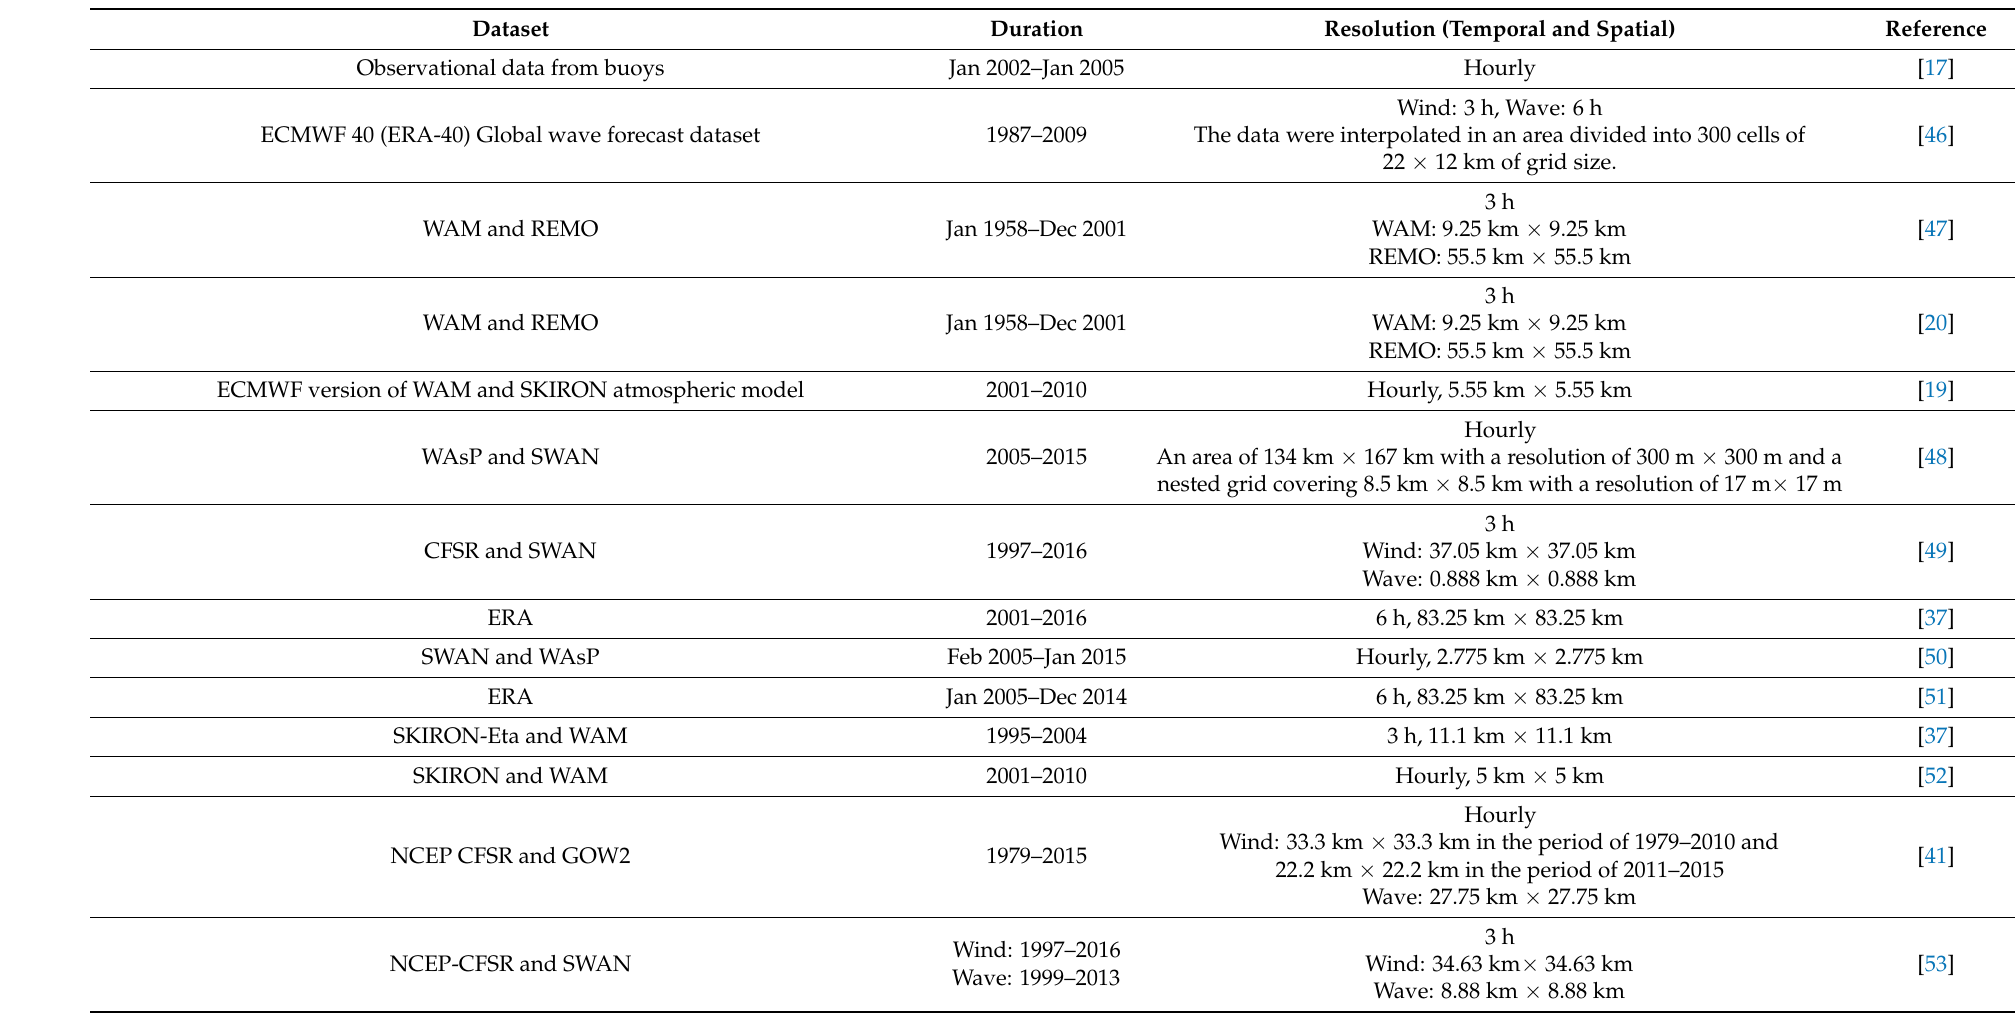
Table 1. Used met-ocean dataset